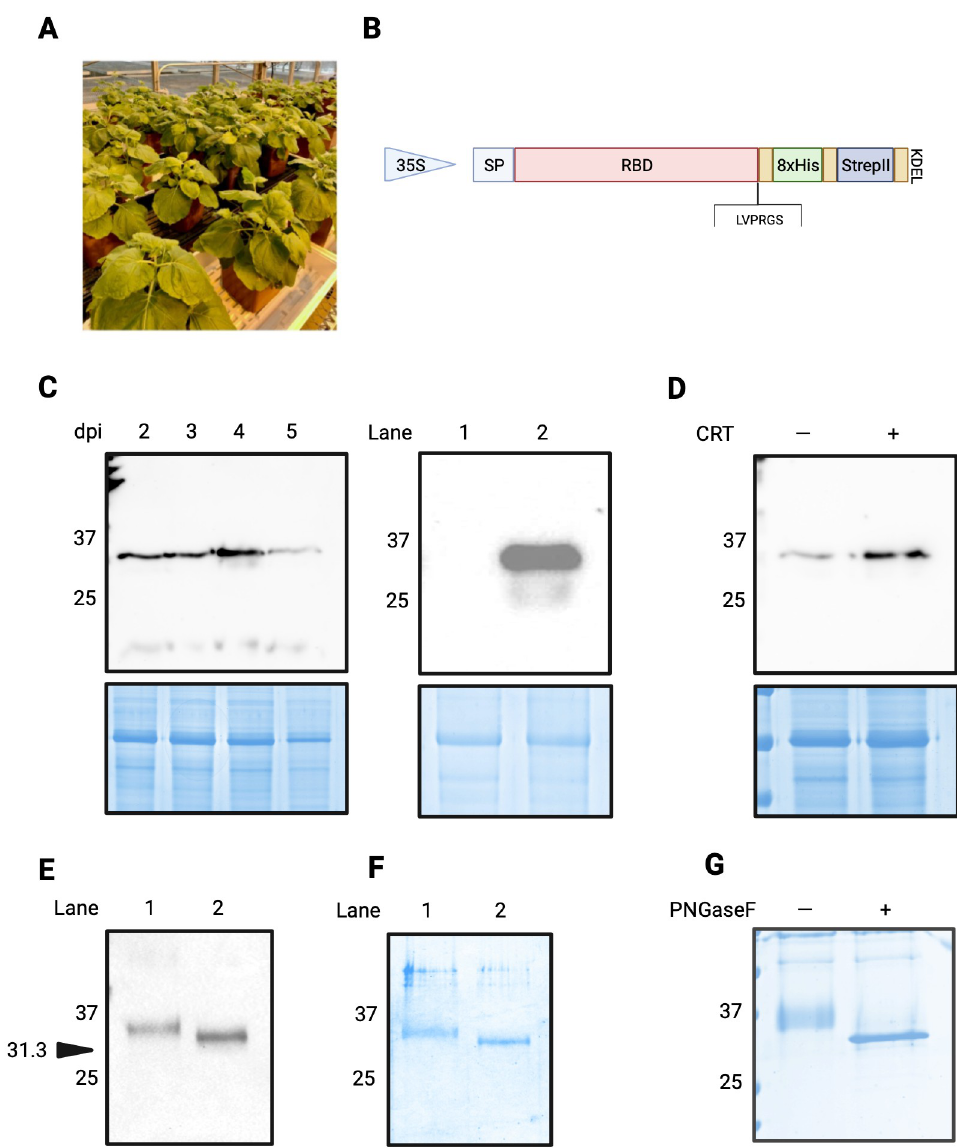
Fig 1. Expression and purification of SARS-CoV-2 RBD in Nicotiana benthamiana . (A) Agro-infiltrated Nicotiana benthamiana growing in greenhouse. (B) Schematic representation of genetic construct used to express SARS-CoV-2 RBD in planta . The SARS-CoV-2 sequence was expressed as a recombinant protein with a dual 8xHis and Twin-Strep II tag, interspersed with Gly-Ser linkers (gold boxes). An ER-retention KDEL sequence was positioned at the C-terminus, and a Thrombin cleavage site (LVPRGS) was included for tag removal. (C) Left panel: Anti-His IB of samples obtained from N . benthamiana 2 to 5 days post-infiltration (dpi) with RBD construct in B. Loading control at 5 dpi reproducibly demonstrates reduced abundance of protein due to initiation of tissue necrosis at this time. Right panel: NT control (lane 1) compared to RBD expressed in N . benthamiana with calreticulin (lane 2). Anti-his IB. (D) Co-infiltration of human calreticulin (CRT) increases expression levels of RBD in N . benthamiana . Samples collected 4dpi. Anti-his IB. (E) Anti- S1 IB of purified RBD expressed in N . benthamiana (lane 1) and control RBD expressed in mammalian 293F cells (lane 2). Arrow indicates expected migration of a protein corresponding to 31.3 kDa. (F) CBB-stained SDS-PAGE of purified RBD expressed in N . benthamiana (lane 1) and control RBD expressed in mammalian 293F cells (lane 2). (G) CBB- stained SDS-PAGE of plant-derived RBD treated with (+) and without (-) the amidase Peptide-N-Glycosidase F (PNGaseF), an enzyme that cleaves N -linked glycan chains. SP, signal peptide. IB, immunoblot. CBB, Coomassie Brilliant Blue. NT, non-transformed.